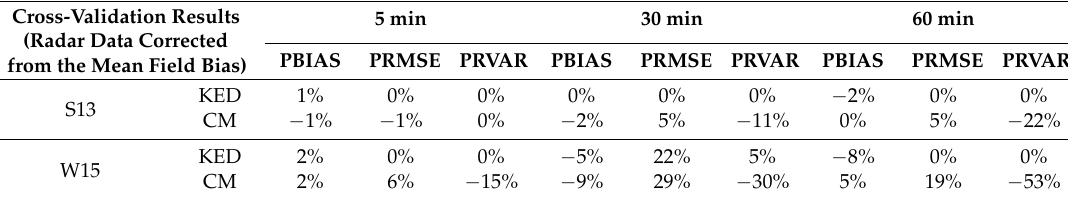
Table 8. The relative improvement in interpolation Performance metrics results for KED and CM when radar data is corrected from the mean field